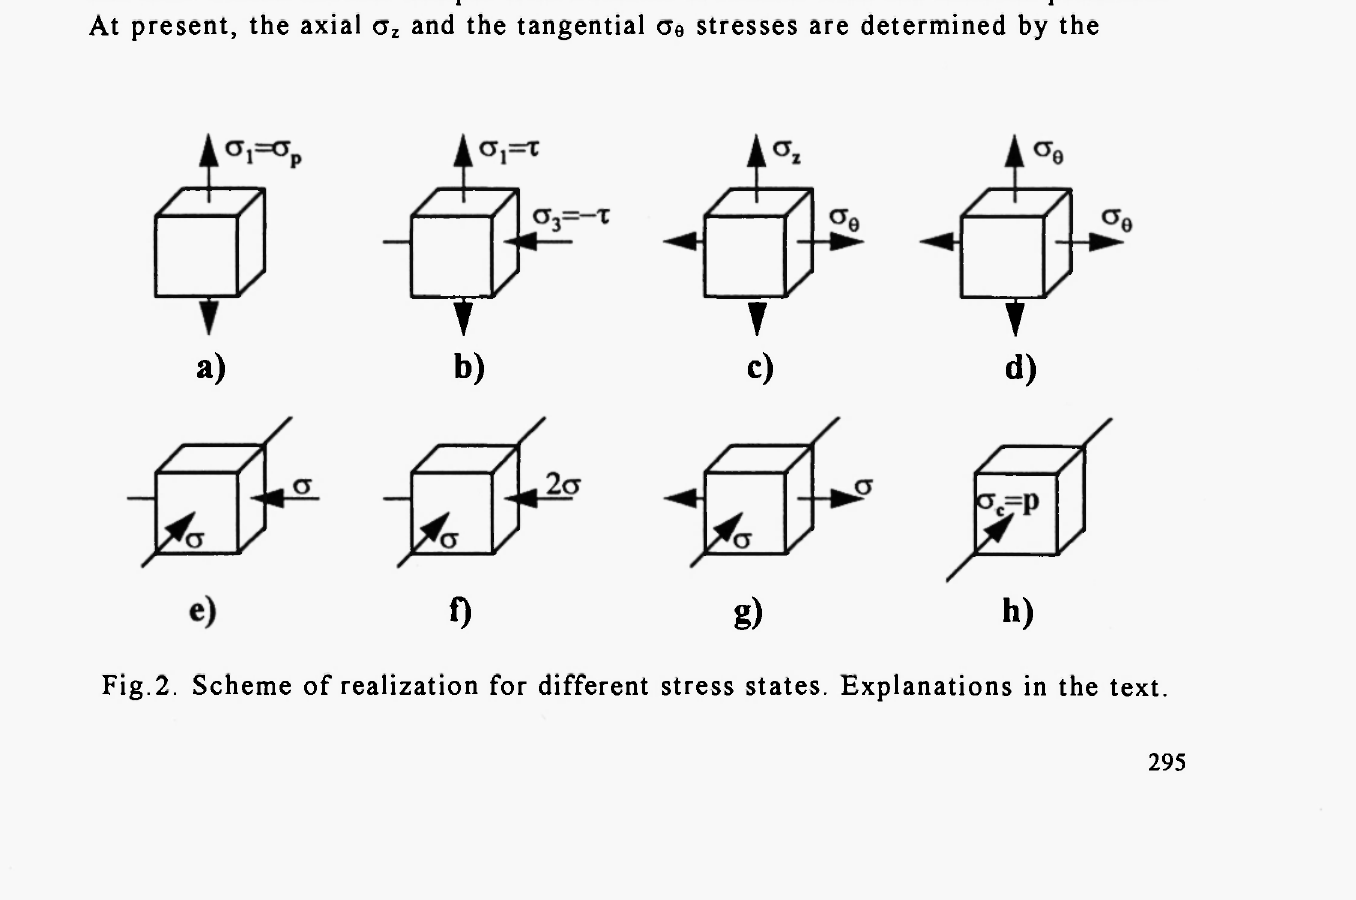
Fig.2. Scheme of realization for different stress states. Explanations in the